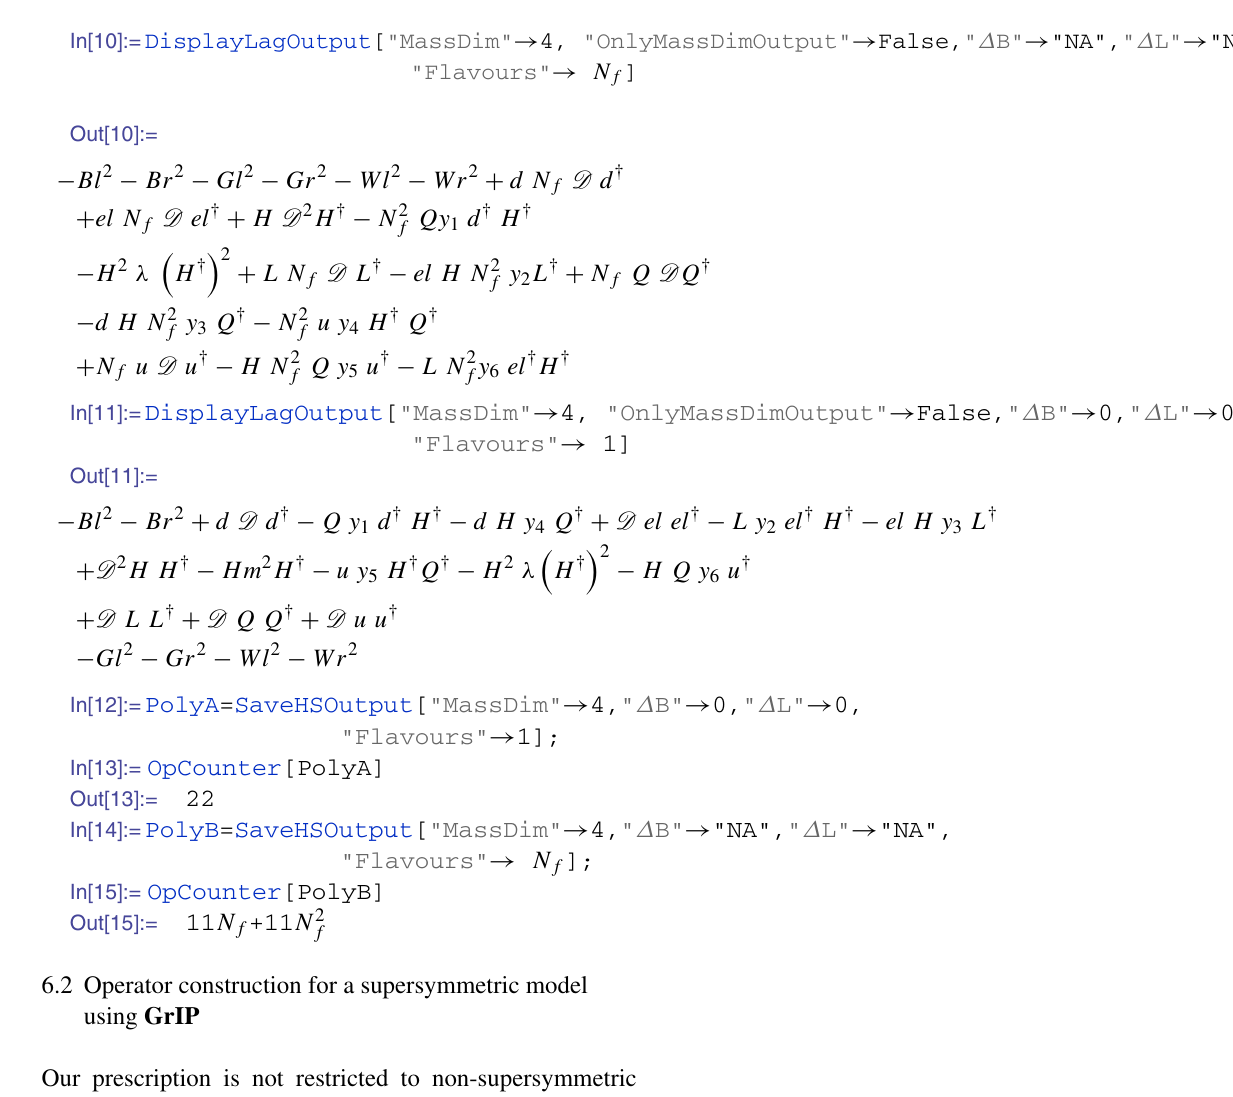
Table 19. The V Φ for this particular scenario is summarized in Table